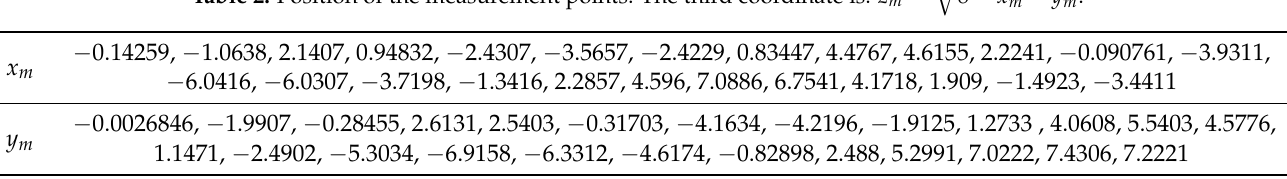
(cid:113) 8 − x 2 m − y 2 m .